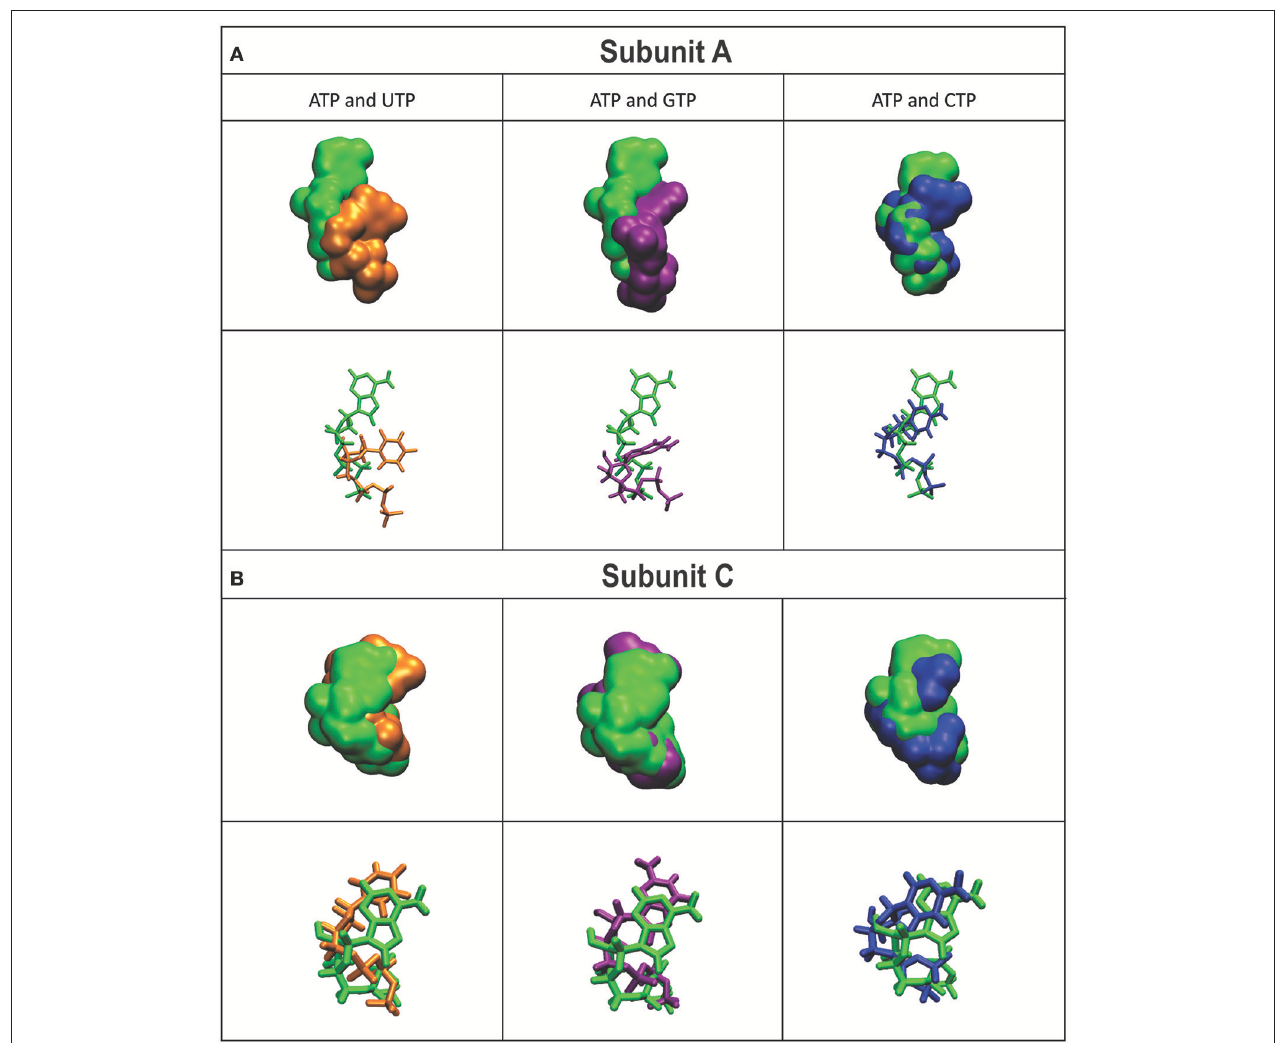
FIGURE 4 | Density volumetric map of NTP Subunit A (A) and C (B) . Top-Volumetric map of ATP (green) over the last 5 ns of MD overlapped with the density volumetric map of NTP. Below-Average NTP structures calculated of the last 5 ns of MD overlapped with the average structures of NTP. Subunits B and D are not shown because they do not contain ligands. The template used to produce the models contains ATP in only subunits A and